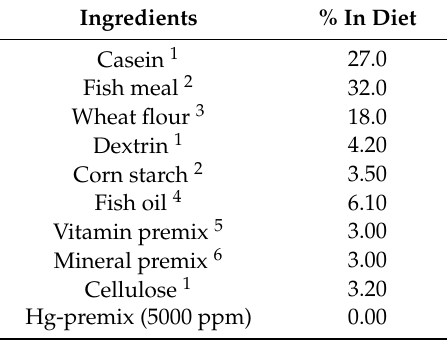
Table 1. Feed formulation and proximate composition of the basal diet (% of dry matter, DM basis). Ingredients